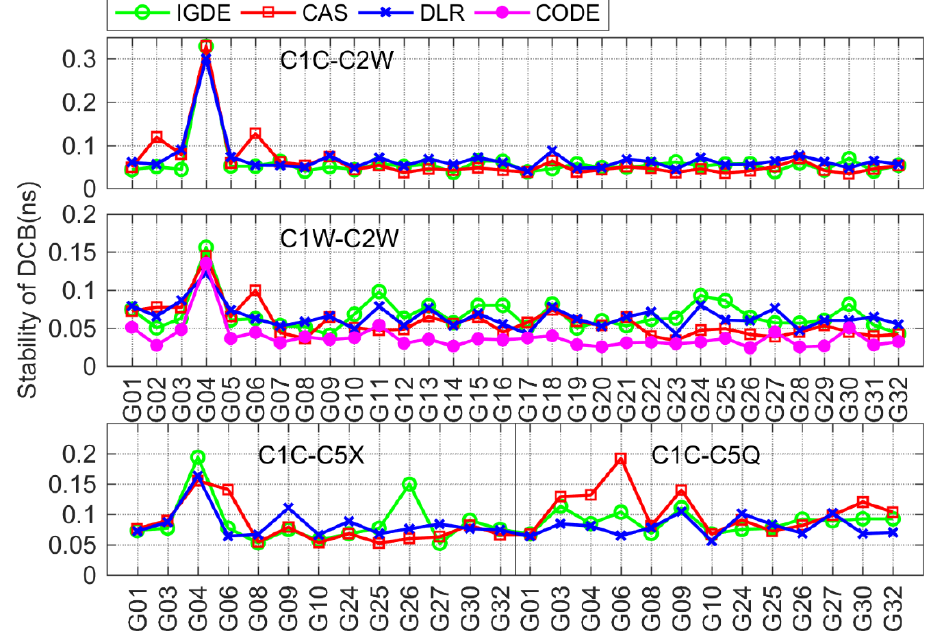
Figure 12. Stability of the GPS DCB obtained by IGDE, CAS, DLR, and CODE.